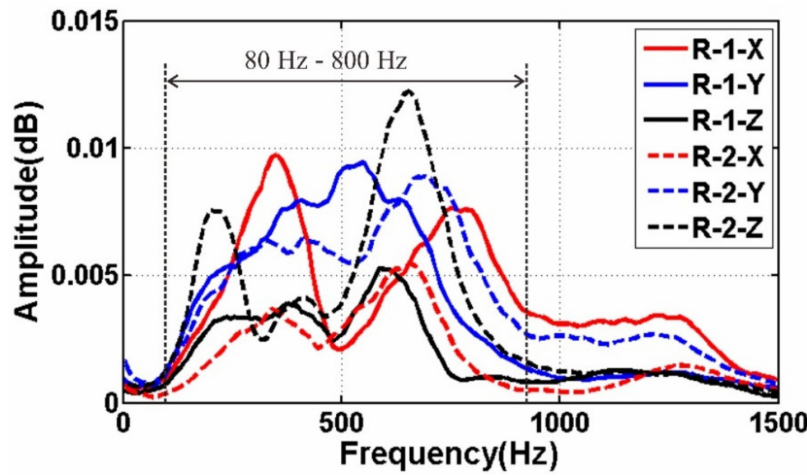
Figure 10. Spectrum analysis results.